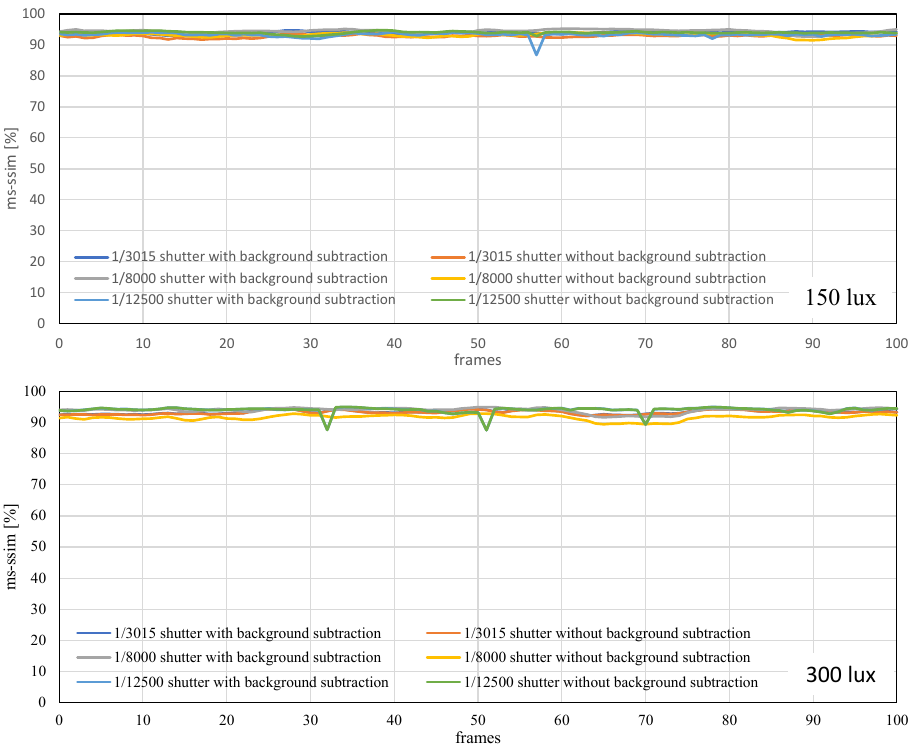
Figure 25. MS-SSIMs when the USB camera video sequence is streamed through HFR projector-1.